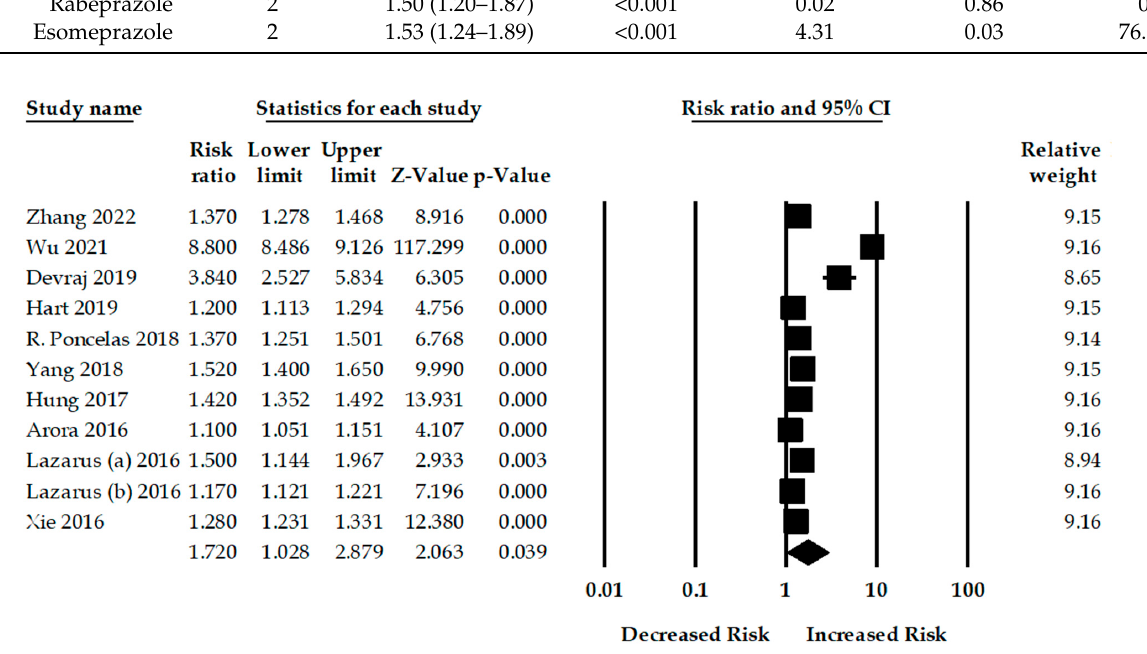
Figure 2. Association between PPI use and risk of chronic kidney disease [15,23–31]. The studies assessed the risk of CKD with esomeprazole; the pooled RR was 1.32 (95% CI: 1.23–1.42, p < 0.001), with non-signi fi cant heterogeneity (Q = 0.82, p = 0.66, I 2 = 0). The pooled RR for studies using rabeprazole and esomeprazole were 1.50 (95% CI: 1.20–